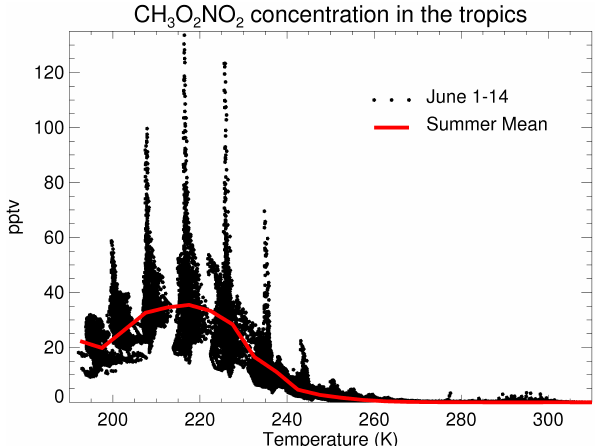
Fig. 5. Tropospheric concentrations of CH 3 O 2 NO 2 versus temper- ature over the tropics. The individual points are the 24h average value of 1–14 June 2008. The red line is the summer mean concen- tration. The regular temperature intervals at low temperatures are a result of decreasing vertical resolution in the model at increasing